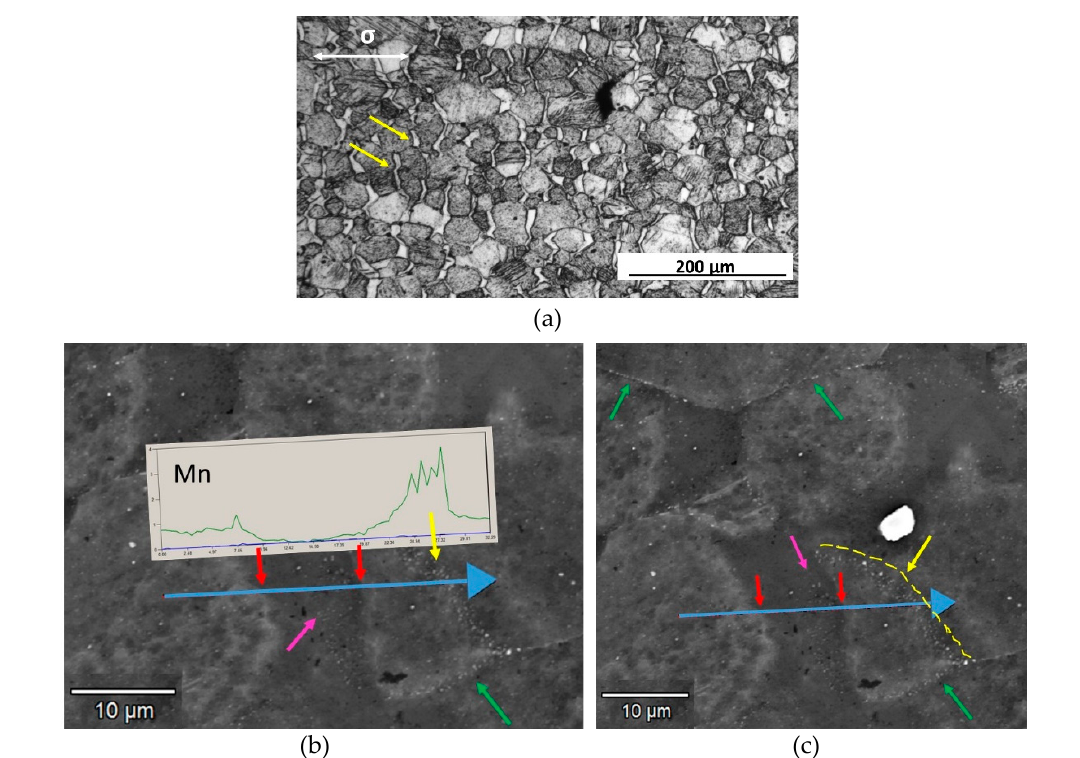
Figure 12. Microstructure after creep, σ = 10 MPa: ( a ) OM, yellow arrows: denuded zones; ( b , c ) EDS measurements, blue arrow indicates the line scan, Mn depleted zones between red arrows, yellow dashed line: migration grain boundary, yellow arrow: undissolved Mn-precipitates, magenta arrow: large Mn-particles, green arrows: Mn-precipitates on grain boundaries